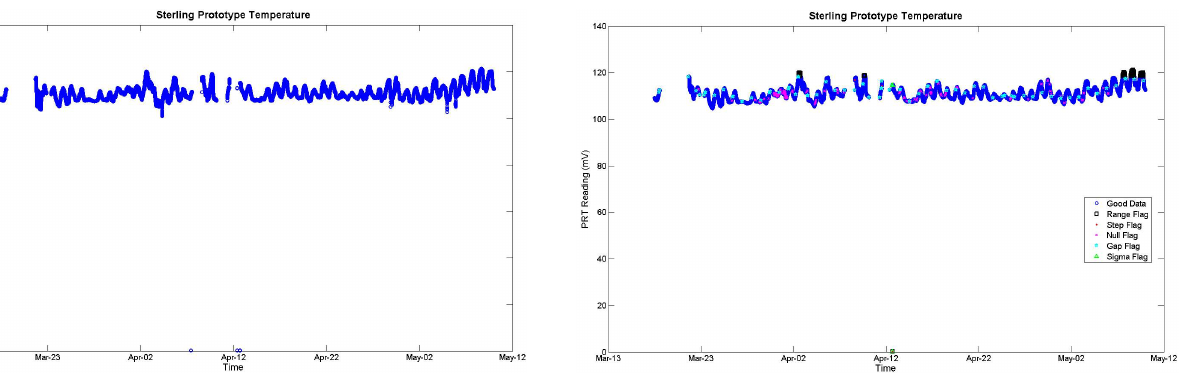
Fig. 9. Time series of platinum resistance thermometer (PRT) ob- servations in March–May 2011 from Domain 10: North Sterling, Colorado. These data were intentionally not calibrated and contain known errors.